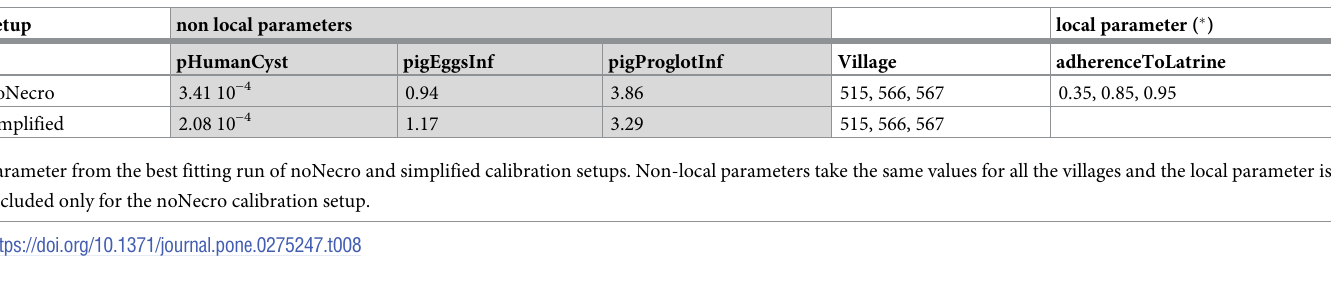
except for PC prevalence in village 515, and better than the noNecro calibration setup in village